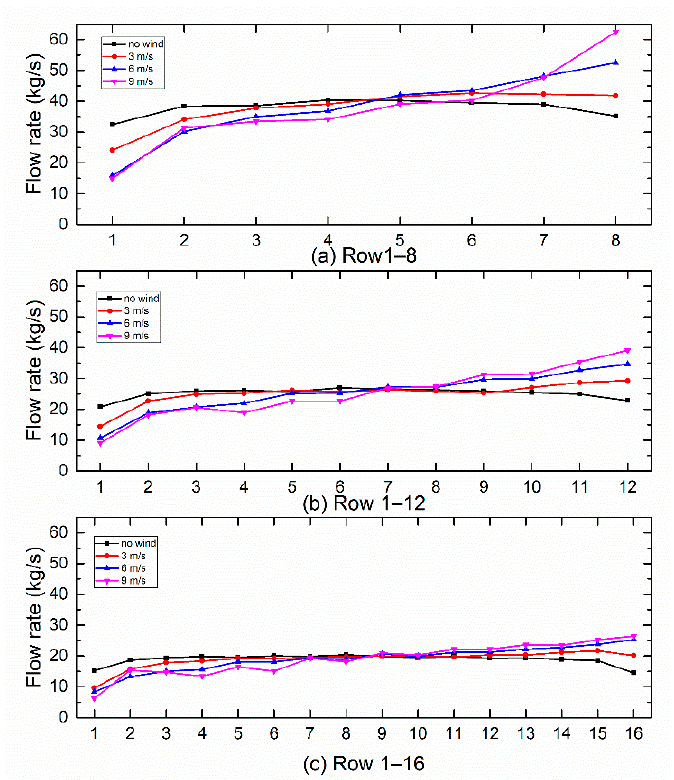
Figure 5. Flow distribution of each cell with di ff erent operation strategies and di ff erent ambient winds.